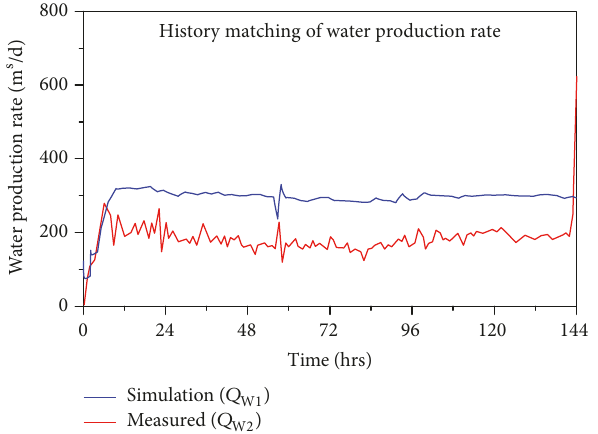
Figure 9: Measured and simulated water production rates ( 𝑄 W ) during the 6-day production test at the AT1 site.